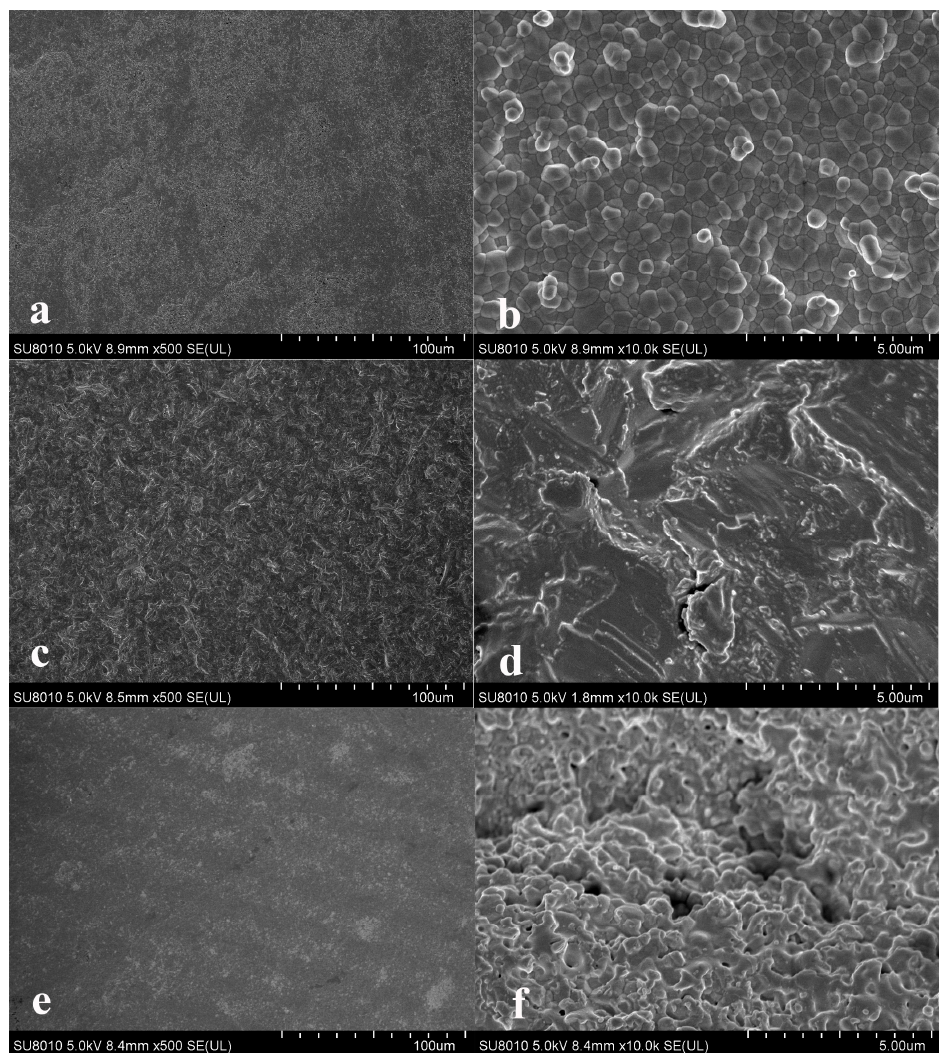
Figure 2. SEM images of zirconia surfaces from different groups at 500× and 10,000× magnifica- tions: ( a , b ) NT; ( c , d ) APA; and ( e , f ) FSL. NT: no treatment group; APA: airborne particle abrasion group; FSL: femtosecond laser group.